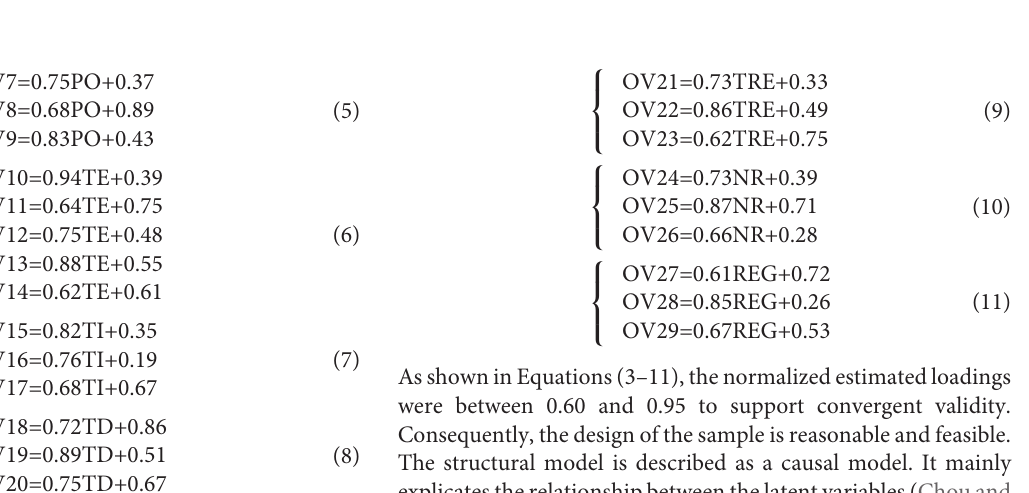
FIGURE 5 | The standardized estimation results from the structural equation model. OV, observation variable; e, error; R, residuals. The values over the arrows manifest relevant normalized regression weights obtained after performing SEM analysis. The inferences drawn here are derived from the pathway estimate